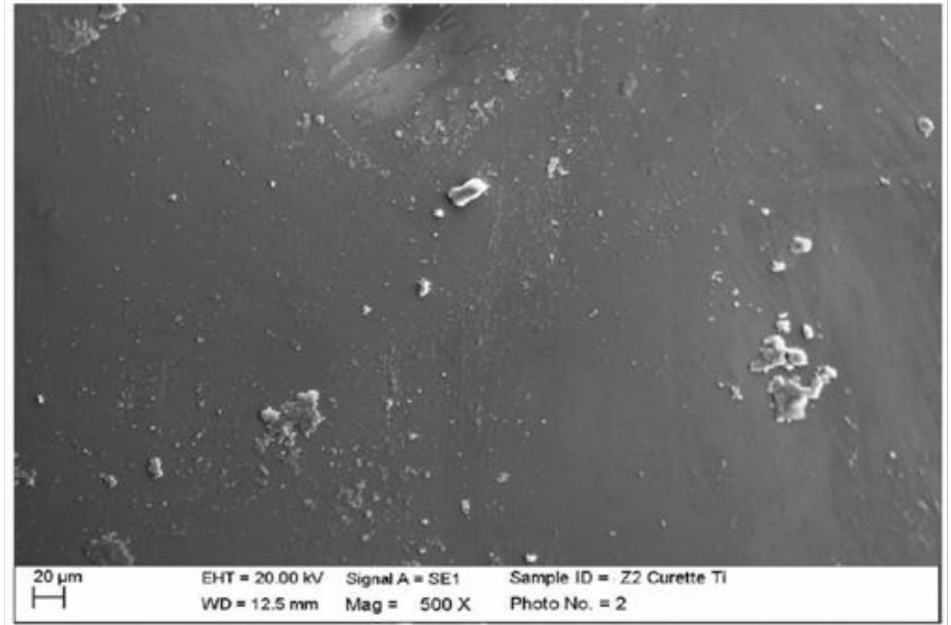
Figure 21. Instrumented zirconium sample Z2 with titanium curette (500 ×